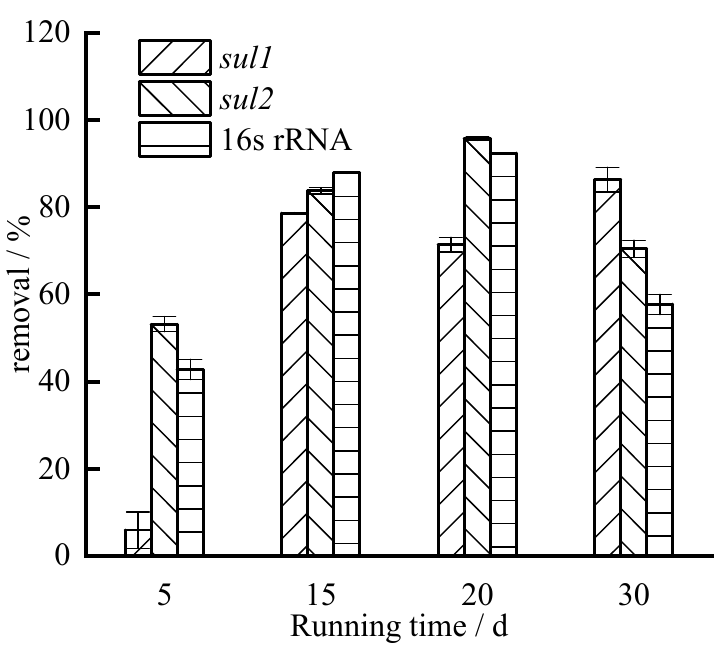
Figure 3. Removal of ARGs.